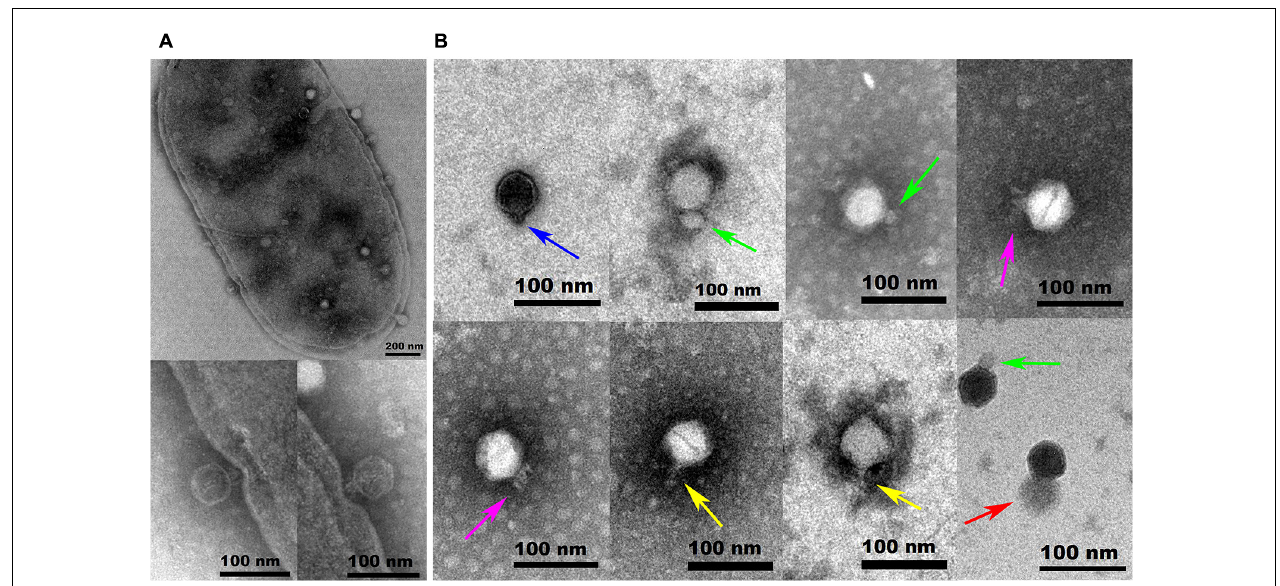
FIGURE 2 | Transmission electron microscopy images of negatively stained Hafnia paralvei LY-23 cell infecting Hafnia phage Ca (A) and Hafnia phage Ca (B) . Hafnia phage Ca particles possessed an icosahedral head with a diameter of 55 nm and a short tail with a length of 4.35–45.92 nm. The tail packaging tightness of Hafnia phage Ca is variable, presenting dot-like (blue arrow), bun-like (green arrow), cone-like with appendages (purple arrow), table tennis racket handle-like (yellow arrow), or ponytail-like (red arrow) shape. Each bun-like tail contains a visible tip sting and may be the tightened state of cone-like tails with appendages. Negative staining and electron microscopy observation, though, were redone four times in different laboratories and consistent results were obtained. The possibility cannot be ruled out that some differences might be artifacts. Cryo-EM observation could be a useful research direction for the phage in the future. The invading phages on the cell surface and the virus particles packaged in the cell are clearly visible (A) . The cell wall in two places (see the enlarged photos at the bottom left for details) was invaginated due to the penetration of Hafnia phage Ca with the cone-like tails.